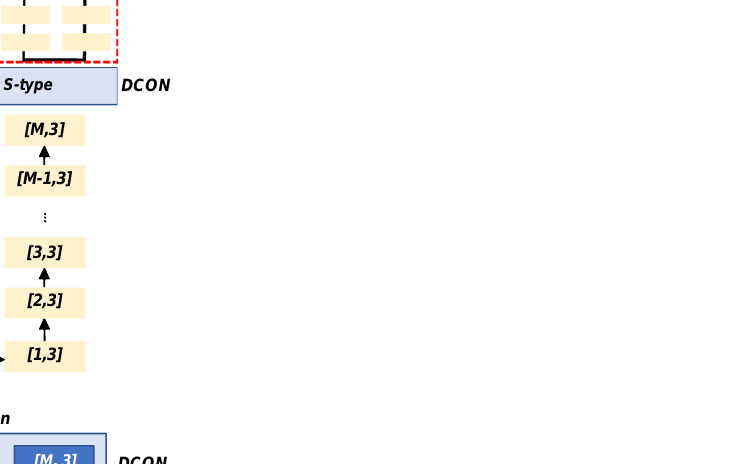
Figure 4. Differential two-dimensional expandable layouts of dimmers and concept of adaptive ad- dressing method.